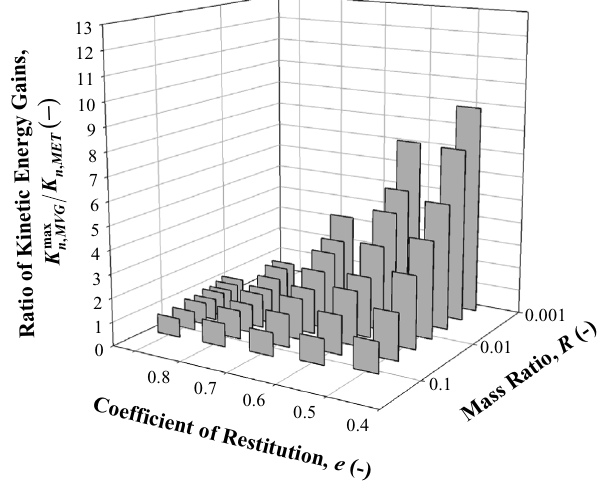
Fig. 14. 3D plot of ratio (MVG/MET) of kinetic energy transfer efficiencies for the top-most mass versus coefficient of restitution and mass ratio. The kinetic energy transfer efficiency for the MVG system is that of the optimal MVG system for the given R,e . (-) means